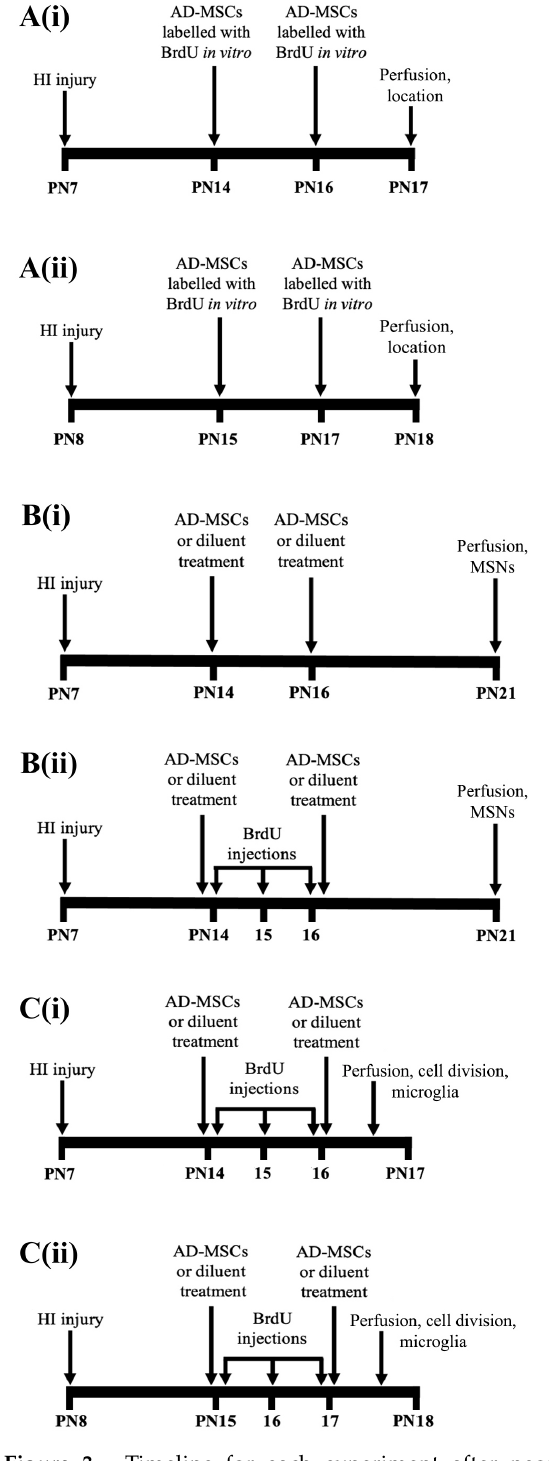
Figure 3. Timeline for each experiment after neonatal hypoxia-ischemia (HI) of the brain. ( A ) Location of injected adipose-derived-mesenchymal stem cells (AD-MSCs) in the brain ( A (i), postnatal day (PN) 7–17; A (ii), PN8–18). ( B ) Effect of treatment with AD-MSCs on the absolute number of all medium-spiny neurons (MSNs, B (i)), and the absolute number of progenitors that had differentiated into MSNs ( B (ii)), in the caudate-putamen (CPu) at PN21. ( C ) Effect of treatment with AD-MSCs on cellular proliferation in the dorsolateral subventricular zone (dlSVZ) and the absolute number of microglia in the CPu and dlSVZ ( C (i), PN7–17; C (ii), PN8–18). BrdU,